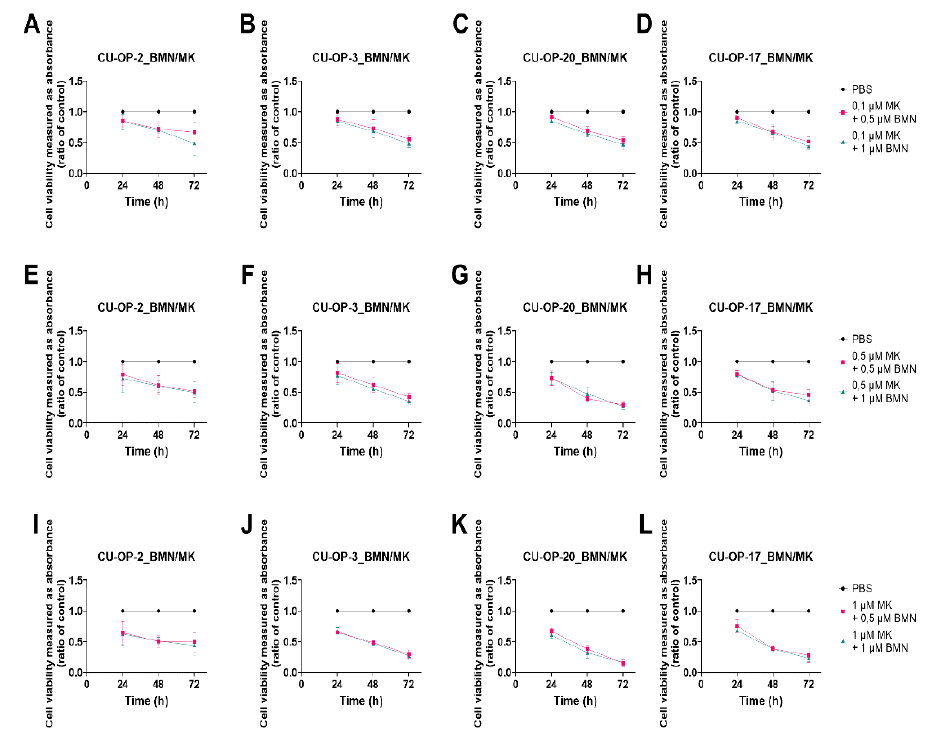
Figure 5. WST-1 viability assay on HPV + cell lines CU-OP-2, CU-OP-3, and CU-OP-20 and HPV − cell line CU-OP-17. Cell viability analysis measured as absorbance after 24, 48, and 72 h of combination treatment with BMN-673 and MK-1775 ( A – L ). BMN denotes BMN-673 and MK denotes MK-1775.